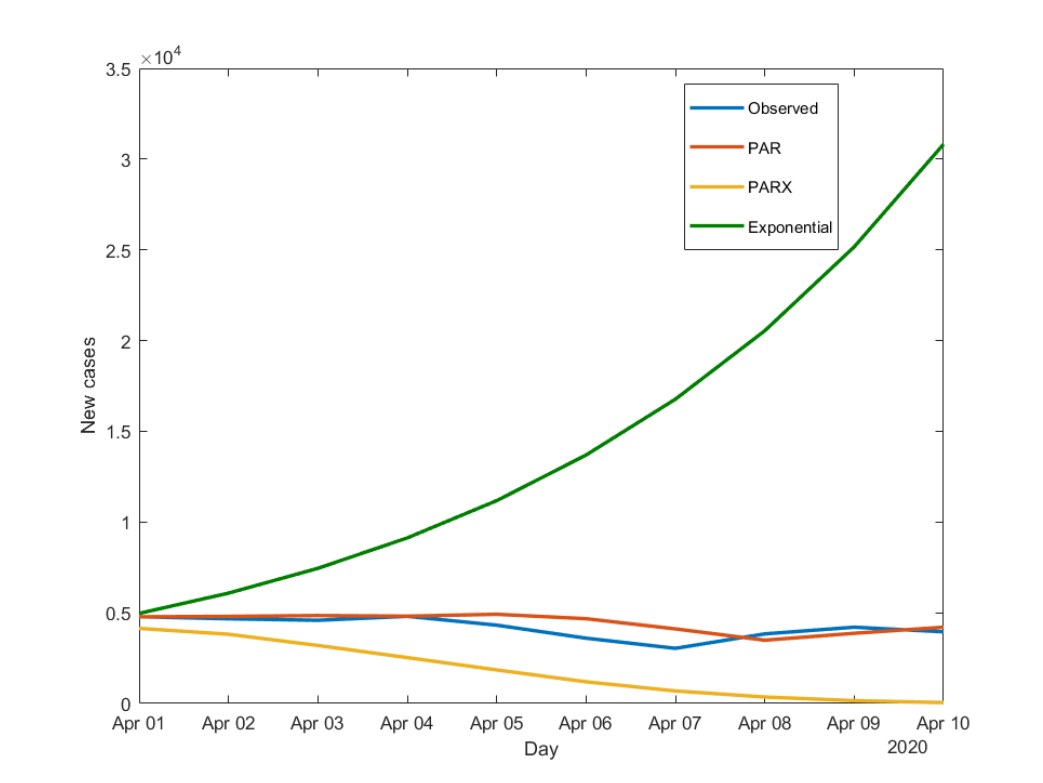
Figure 5. Daily infection counts in Italy: observed and predicted